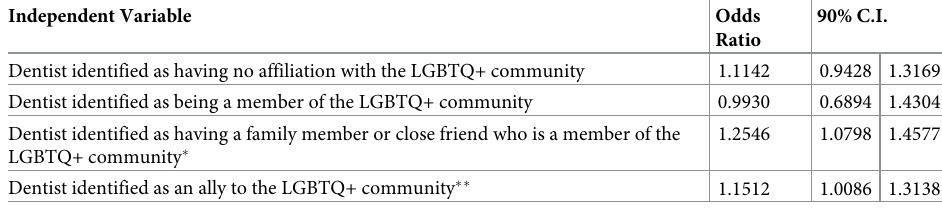
90% C.I. Ratio 1.2546 1.0798 1.4577